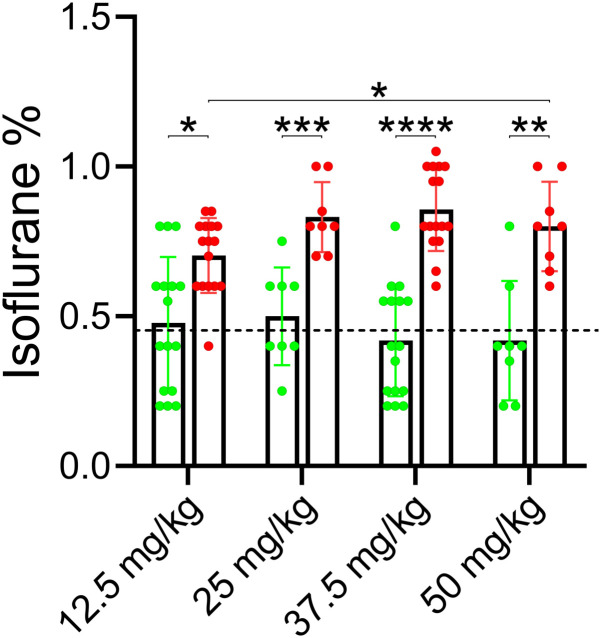
Increasing the caffeine concentration infused into rats caused the animals to emerge from anesthesia at a higher isoflurane concentration.The protocol employed for this experiment was identical to that shown in Fig 1. Four different caffeine concentrations were tested, each one in a separate group of rats. Caffeine and saline were injected in alternate anesthesia sessions for each group. Group 1, 16 rats, were tested with 12.5 mg/ kg caffeine. Group 2, 8 rats, were tested with 25 mg/ kg caffeine. Group 3, 16 rats, were tested with 25 mg/ kg caffeine. Group 4, 8 rats, were tested with 50 mg/ kg caffeine. The isoflurane levels at RORR were recorded and then averaged for each group of rats and then plotted as a bar chart (± SD). The individual isoflurane values at RORR are superimposed on top. The data was analyzed with a mixed-effects ANOVA, without assuming sphericity and using Tukey’s multiple comparison test. Significant differences between groups is shown graphically with a line with stars superimposed representing the level of significance. Group 1 saline vs group 1 caffeine, p = 0.02. Group 2 saline vs group 2 caffeine, p = 0.0003. Group 3 saline vs group 3 caffeine, p < 0.0001. Group 4 saline vs group 4 caffeine, p = 0.0086. For emergence in caffeine the following comparisons were observed. Group 1 caffeine vs group 2 caffeine, p = 0.5. Group 1 caffeine vs group 3 caffeine, p = 0.0539. Group 1 vs group 4, p = 0.04. Group 2 caffeine vs group 3 caffeine, p = 0.9985. Group 2 caffeine vs group 4 caffeine, p = 0.9998. Group 3 caffeine vs group 4 caffeine, p = 0.9895. To examine reproducibility of the data the following comparisons were made: Group 1 saline vs group 2 saline, p = 0.9995. Group 1 saline vs group 3 saline, p = 0.9911. Group 1 saline vs group 4 saline, p = 0.9985. Group 2 saline vs group 3 saline, p = 0.9809. Group 2 saline vs group 4 saline, p = 0.9903. Group 3 saline vs group 4 saline, p > 0.9999.